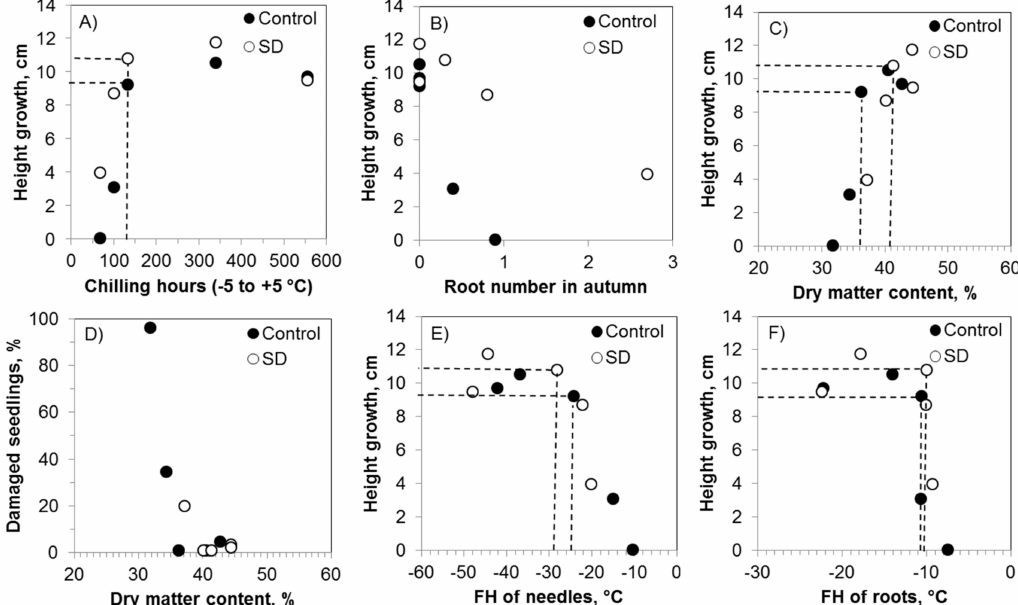
Figure 7. Relationship between height growth at the end of the first growing season in the field (2013) and ( A ) chilling hours, ( B ) root number in autumn, ( C ) dry matter content, ( E ) frost hardiness of needles and ( F ) roots in autumn that were measured on the dates of the freezing tests (Table 1) and used to predict the storability of Norway spruce seedlings that either received short-day (SD) treatment or did not (control). ( D ) The relationship between damaged seedlings at the end of the first growing season in the filed and dry matter content are also presented. FH = frost hardiness ( DT 50 , the temperature at which the degree of damage of needles, stem or buds, or root number was reduced by 50%). Dotted lines indicate the point at which the seedlings reached storability (determined as post-storage root growth potential and first-year height growth; see Figures 4 and